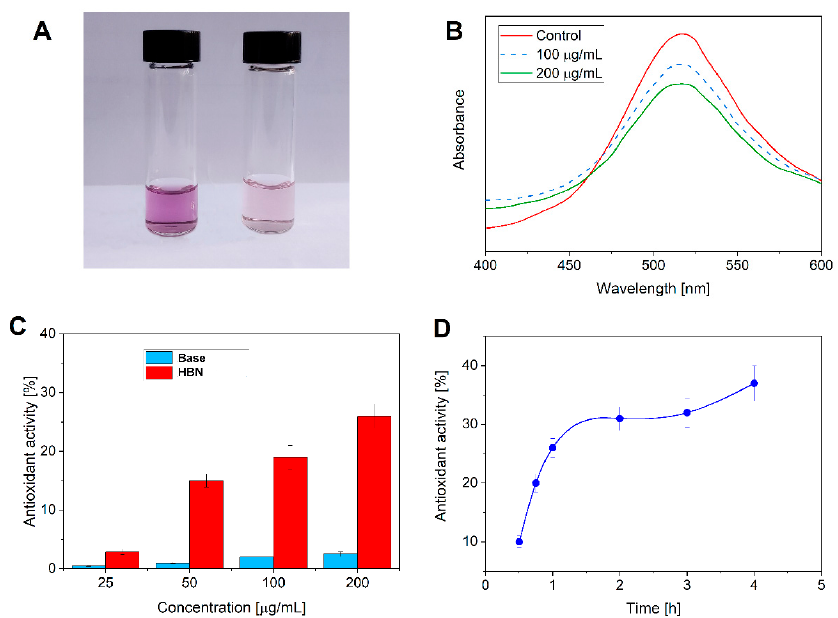
Figure 7. ( A ) Photograph of samples with Base (left) and HBN formulation (right). ( B ) UV-visible spectra of the control and samples containing 100 and 200 μ g/mL. ( C ) Effect of concentration on the antioxidant activity. ( D ) Effect of time on the antioxidant activity of solutions containing 200 μ g/mL.